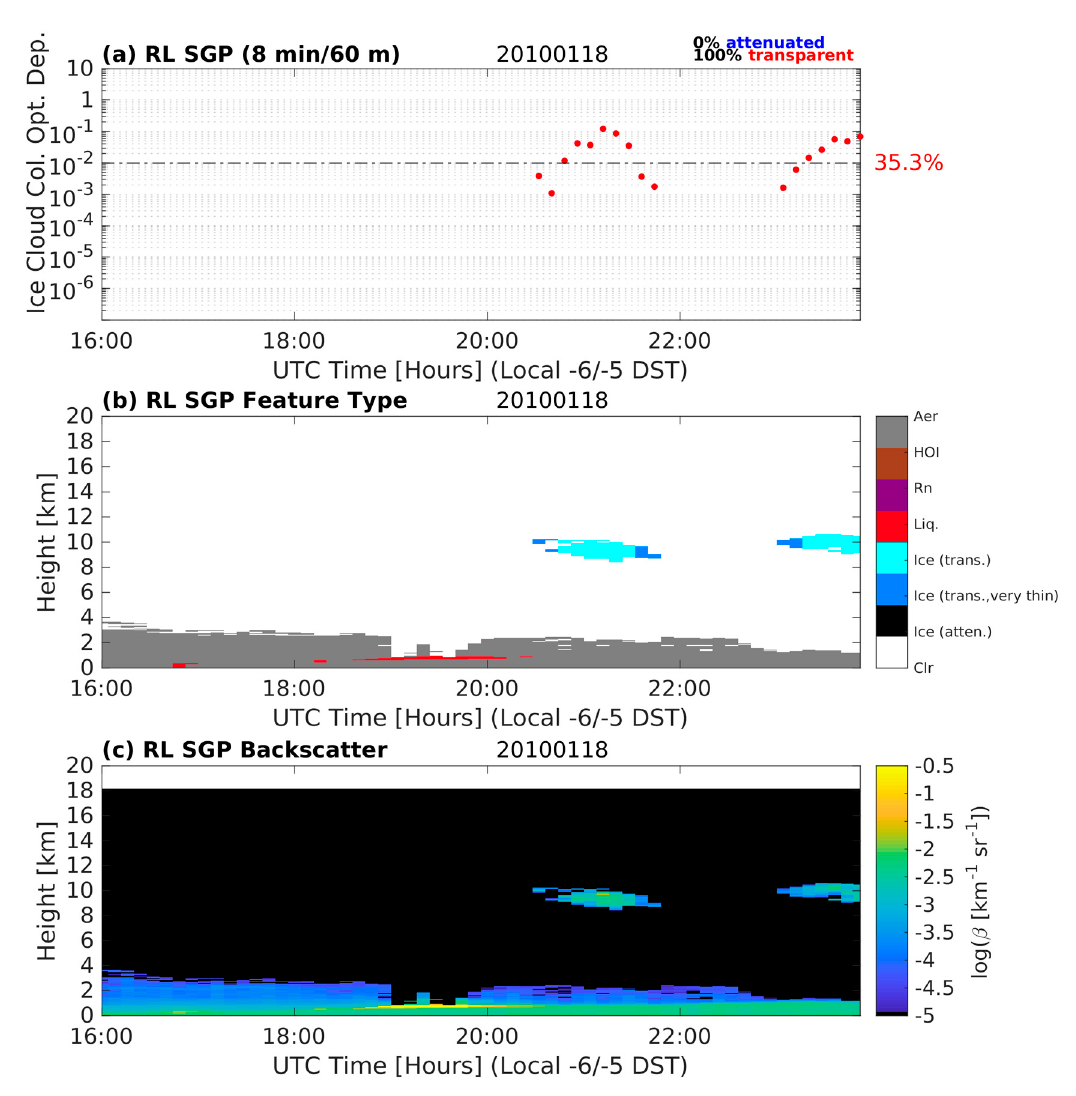
Figure 1. Raman lidar (RL) retrievals on 18 January 2010 at the Southern Great Plains (SGP) site for collocated profiles with Cloud-Aerosol Lidar and Infrared Pathfinder Satellite Observations (CALIPSO) ( ± 4 h). ( a ) Ice cloud column optical depths for transparent profiles (red) and attenuated profiles (blue) versus time in UTC. The optically very thin ice cloud threshold ( τ i , c < 0.01) is denoted by the dot-dashed black line. The percentage of transparent ice cloud column optical depths below this threshold compared to all transparent ice cloud column optical depths for this collocated section is labeled to the right of the graph. The percentage of ice cloudy profiles that are transparent and attenuated are given above the graph to the right. ( b ) Feature classification as either liquid cloud (red), rain (purple), horizontally-oriented ice (HOI; brown), aerosol (gray), transparent ice clouds with τ i , c ≥ 0.01 (light blue), transparent ice clouds with τ i , c < 0.01 (dark blue) or attenuated ice clouds (black). ( c ) Particulate backscatter ( β , expressed as the log, units: km − 1 sr − 1 ) for all features detected.